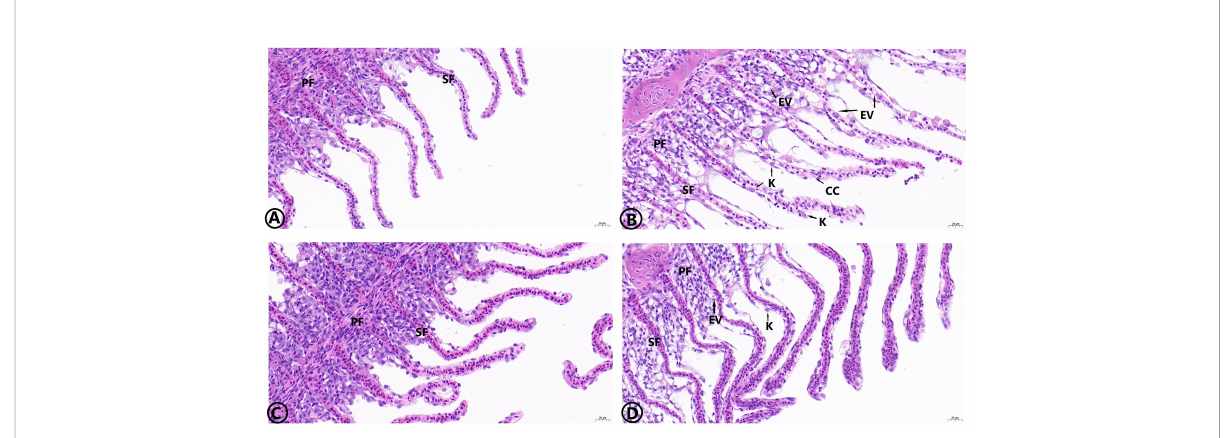
FIGURE 8 Effects of dietary MOS on the histological structure of gills of the common carp under ammonia stress for 30 days. Stain H&E. Bar = 20 m m, 40.00X. Control group (A) , ammonia group (B) , MOS group (C) , and MOS/Am group (D) . PF, Gill fi lament; SF, Gill patch; EV, Cell vacuolation; K, Cell nuclear deviation; CC, In fl ammatory cells.